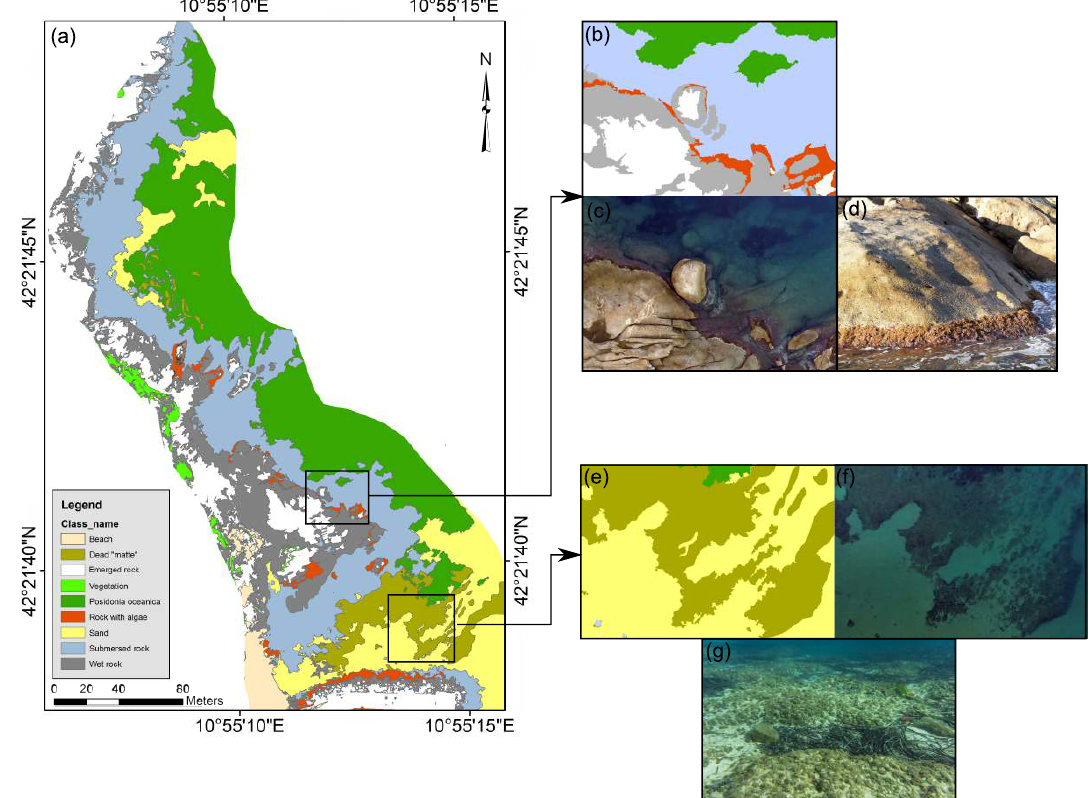
Figure 8. The classified orthophoto ( a ) through OBIA method of the S2 site showing some important features characterizing this coastal environment, such as arborescent macro-algae ( Cystoseira spp.) belts ( b – d ); and a degraded area of the P. oceanica meadow (represented by dead ‘matte’) near to the port ( e – g